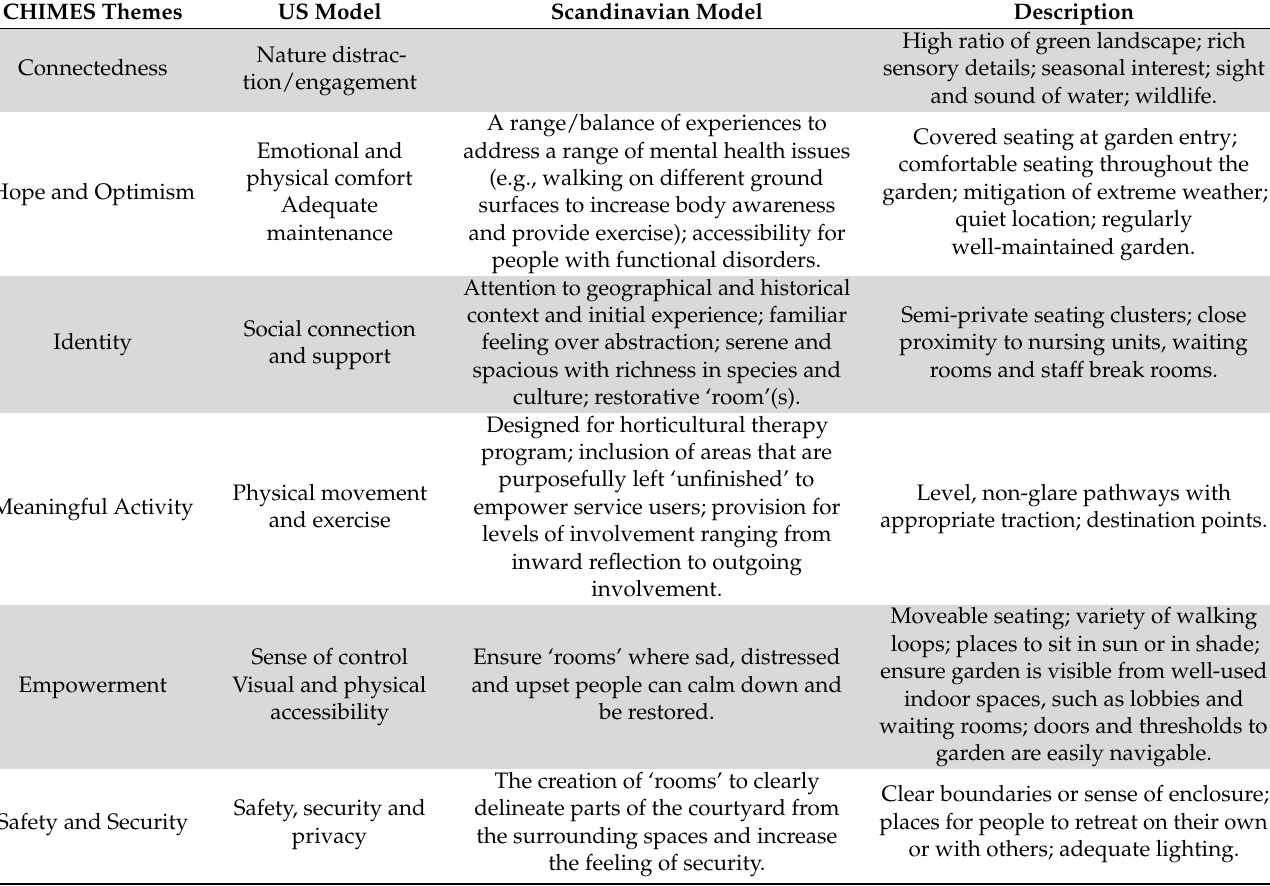
Table 3. A comparison of leading US and Scandinavian models and frameworks with the CHIMES model (adapted from